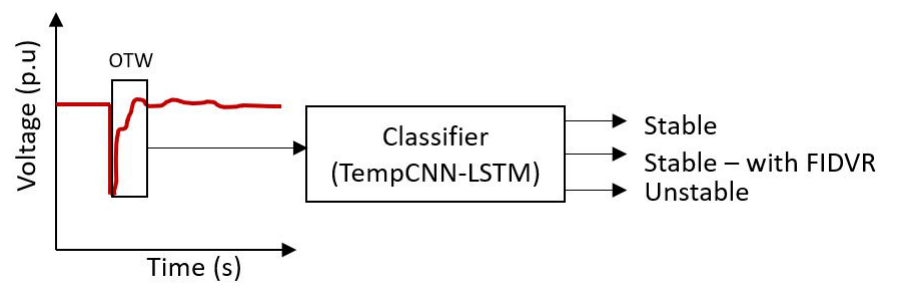
Figure 3. Proposed method for real-time